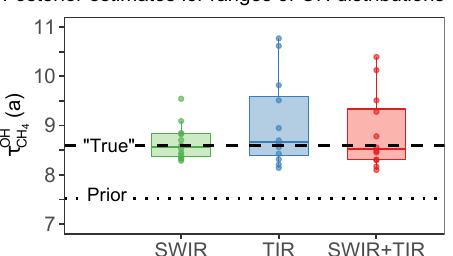
Figure 10. Effect of error in OH distribution on the optimization of the global OH concentration (methane lifetime τ OH lite observations. The figure shows the posterior estimation of τ OH using 12 different OH distributions (Fig. 9) in simulations of the true atmosphere sampled by SWIR, TIR, and SWIR + TIR instru- ments, in comparison with true (dashed line) and prior (dotted line) τ OH . The boxes represent the 75th and 25th percentiles, solid lines CH 4 inside the boxes represent the medians, the whiskers represent the maximum and minimum, and dots represent results for each OH distribution.